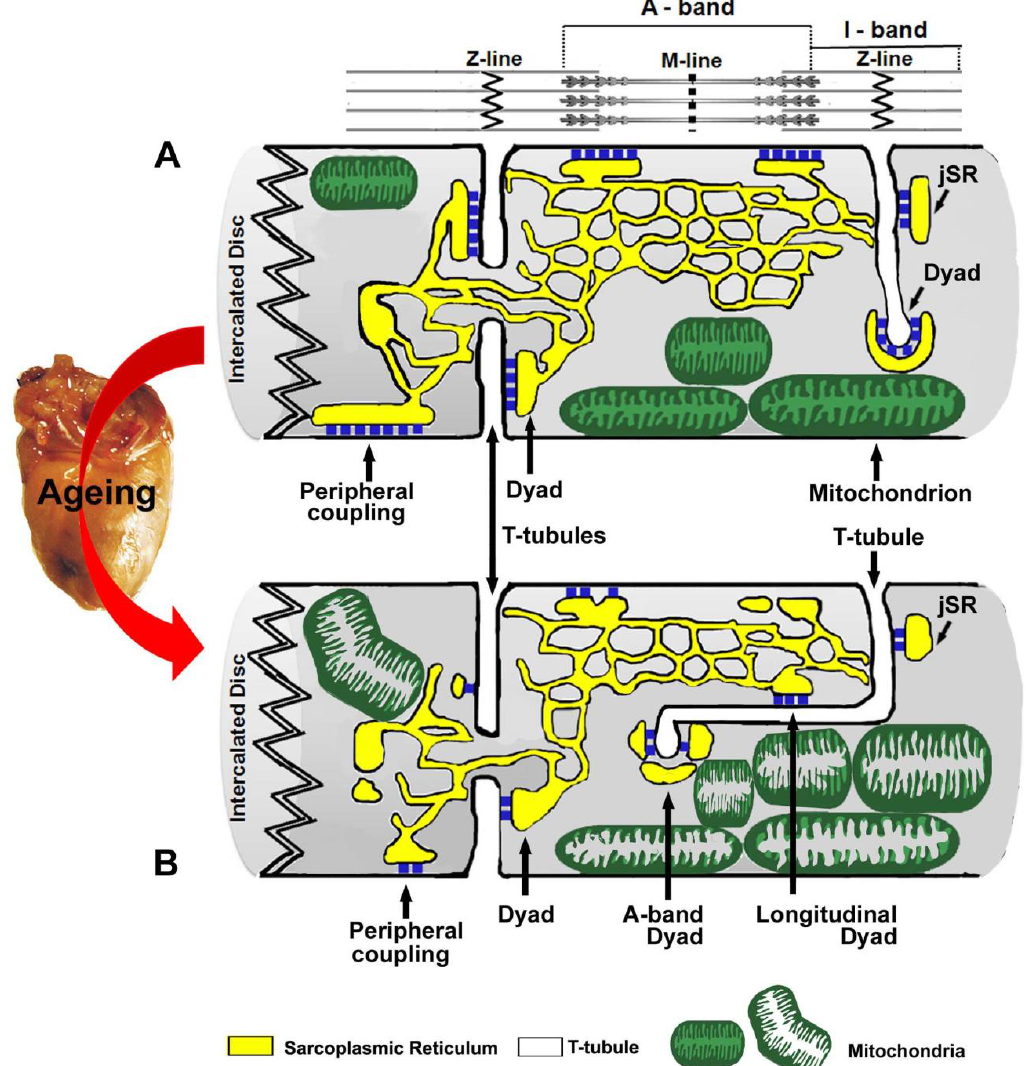
Figure 7. Modeling of age-related changes affecting mitochondria and Ca 2+ release units (CRUs) in cardiomyocytes. ( A ) Disposition of mitochondria and CRUs in adult cardiomyocyte. ( B ) Aging causes (a) mitochondrial damage (shown in ( B ) by a pale interior) and their abnormal grouping, (b) a significant reduction in the average number and size of CRUs (peripheral couplons and dyads), and (c) an increased frequency of longitudinally oriented dyads. Colour legend: SR in yellow; T-tubule in white; mitochondria in green; RYR2 in blue.